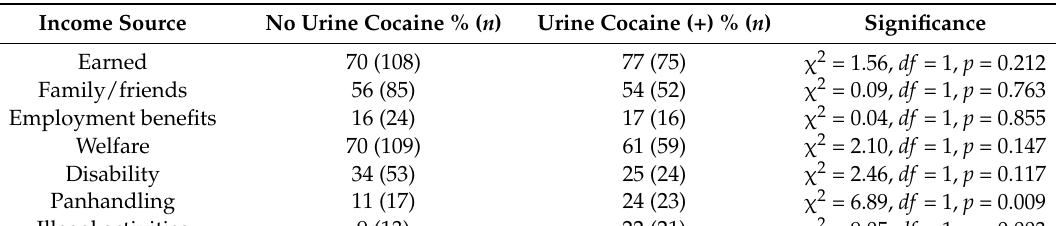
Table 1. Proportions with 30-day income sources at any time point among those with and without a positive urine cocaine test at any time point.